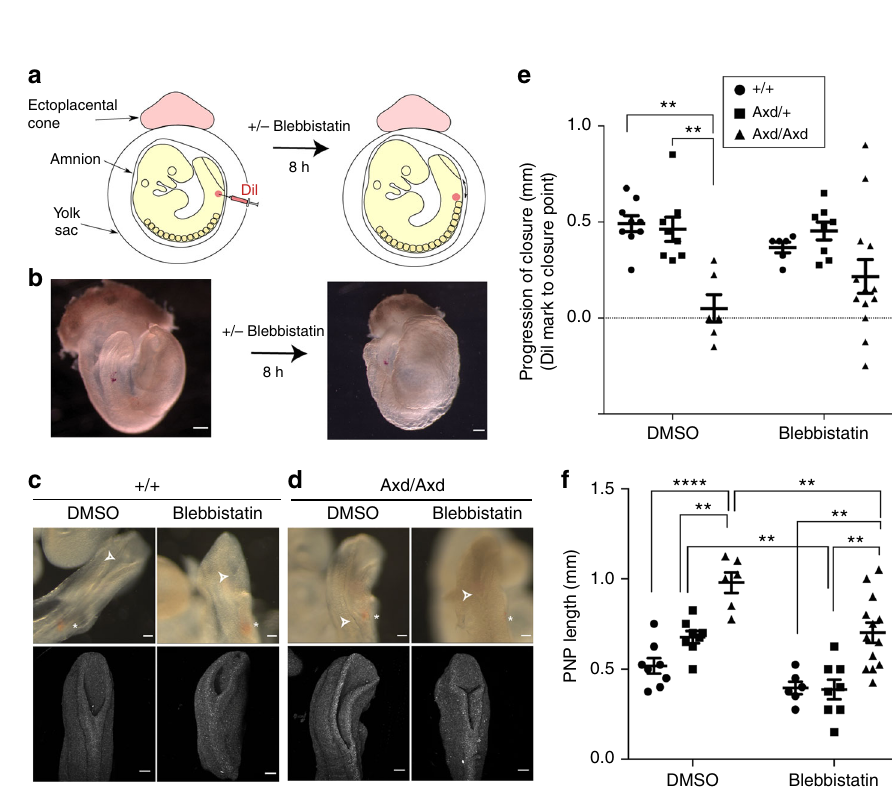
Fig. 9 Partial rescue of PNP closure in Axd/Axd embryos by myosin II inhibition. a Diagram of experimental approach and b representative images of embryos, contained within the yolk sac after DiI marking and after 8 h culture (scale bars represent 500 µ m). c , d Light (upper row) and confocal (lower row) images of the PNP region (caudal end oriented upwards) after culture in the presence of vehicle or 50 µ M blebbistatin (effective dose is higher than in Fig. 8 as the yolk sac is open). Asterisks indicate the position of the DiI mark and arrows indicate the neural tube closure point (scale bars represent 100 µ m). e Progression of closure is diminished in Axd/Axd embryos compared to other genotypes when cultured in vehicle only, but not after culture with blebbistatin. f PNP length is greater in Axd/Axd embryos than in other genotypes in both treatment groups but blebbistatin-treated mutants have a smaller PNP than vehicle-treated mutants ( n > 6 per group; ** p < 0.01, *** p < 0.0001, One-Way ANOVA). Source data are provided as a Source Data fi